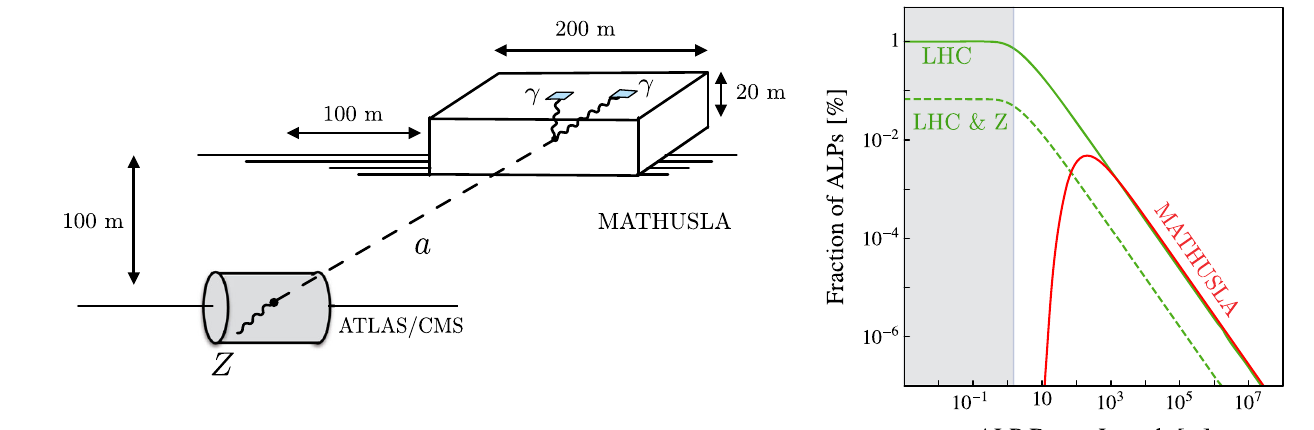
Fig. 17 Left: geometric setup of the MATHUSLA surface detector abovetheATLAS/CMScaverntogetherwithasketchofthe pp → h → aZ process with a subsequent decay of the ALP in the MATHUSLA detector volume. Right: Total percentage of ALPs decaying within the ATLAS or CMS detector per ALPs produced in the Higgs decay